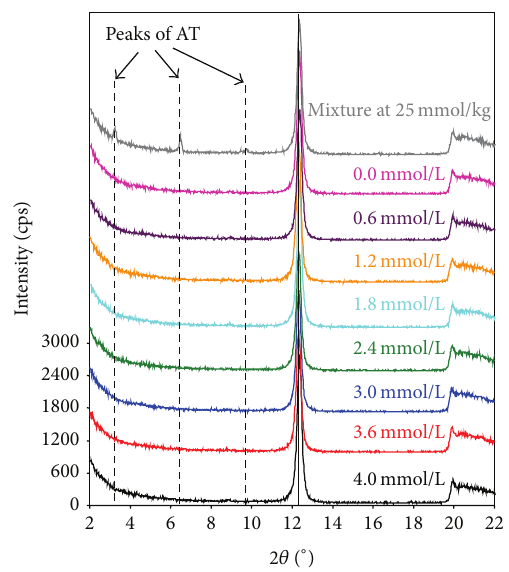
Figure 8: X-ray diffraction patterns of kaolinite adsorbed with different amounts of AT. The values are initial AT